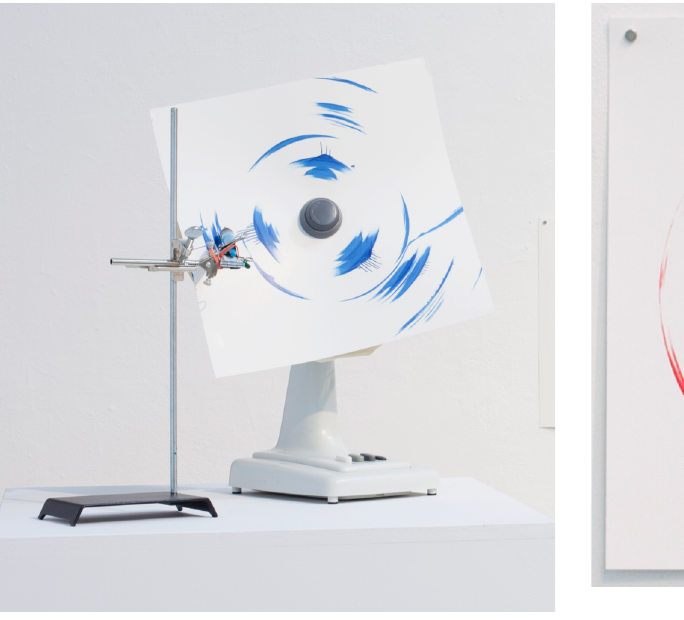
Figure 9 | The Ventilator. Drawing machine. Figure 7 illustrates another unpremeditated result: ink blobs appearing when a defective pen was rotated rapidly, literally embodying the ‘messy’ conditions that Cramer identified as belonging to analog media.